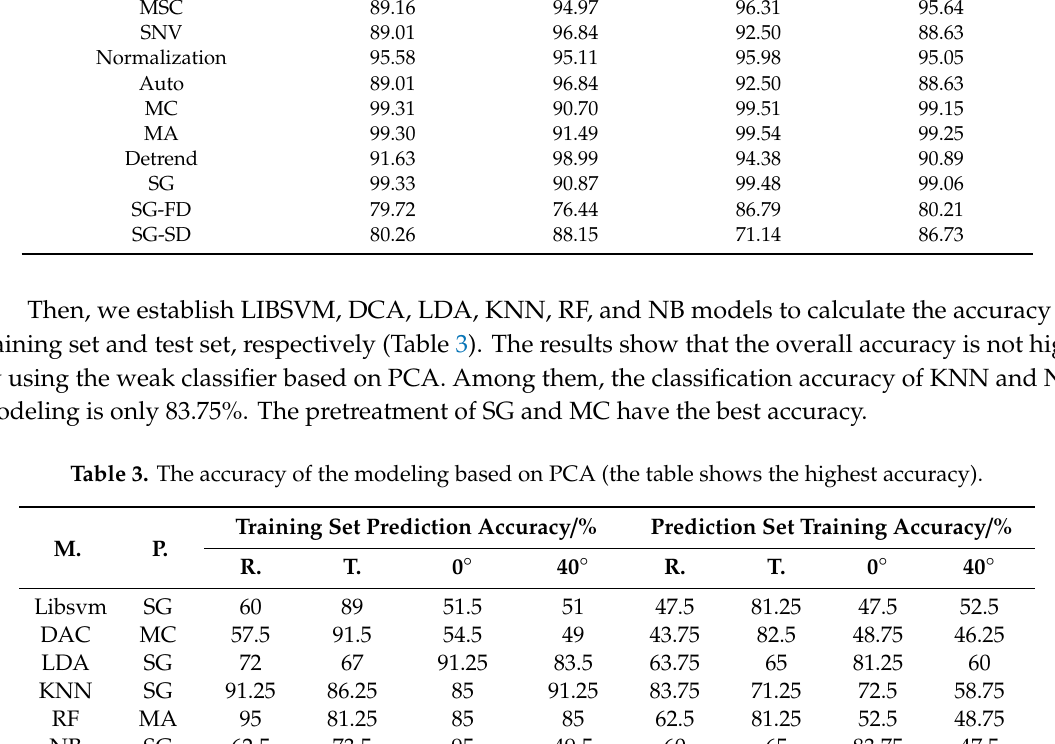
Table 2. Cumulative contribution rates of the first three principal components.